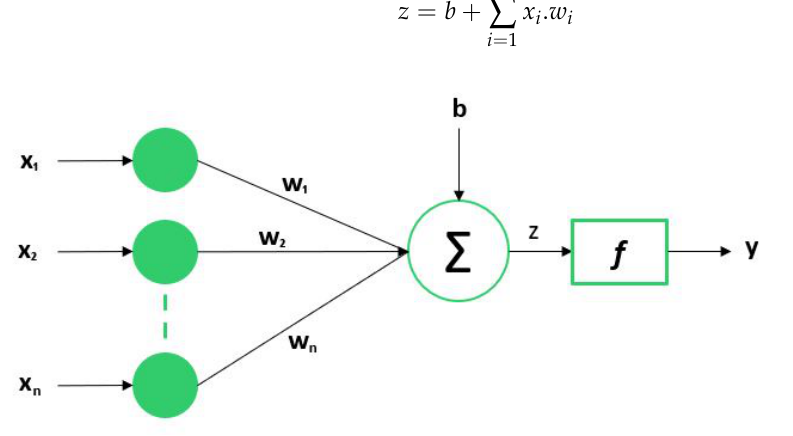
Figure 4. The structure of a perceptron: x i represent the input signals, w i denote synaptic coefficients, b is a bias, f is an activation function and y is the output